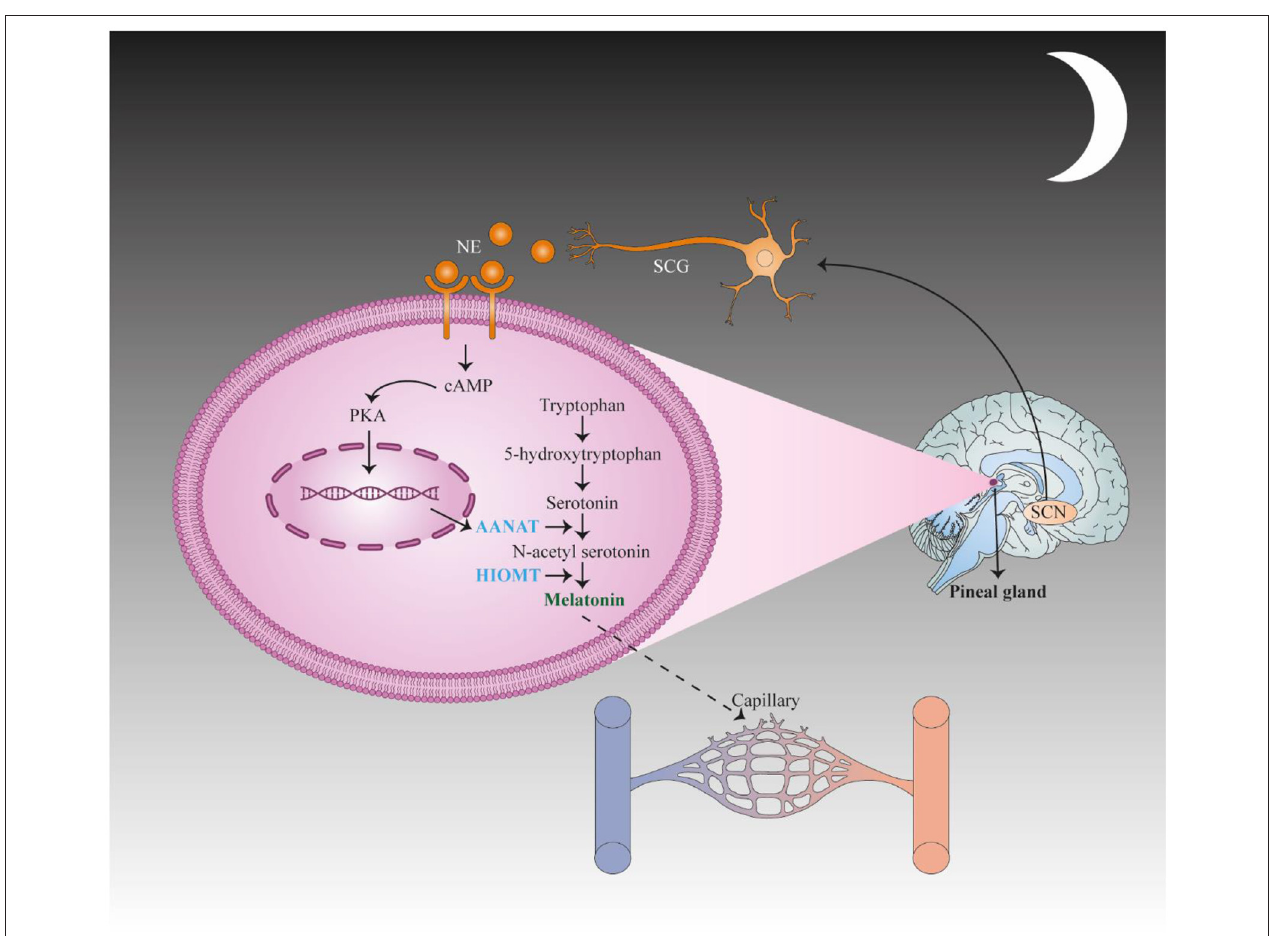
FIGURE 2 | First, the suprachiasmatic nucleus (SCN) translates stimulation to the spinal cord and the superior cervical ganglia (SCG) of the sympathetic nervous system and subsequently activates adrenergic fibers to secrete norepinephrine (NE), which binds to adrenergic receptors in pinealocytes. These changes result in the up regulation of N-acetyltransferase (AANAT), the key enzyme in melatonin synthesis, via activating CAMP signaling. This change causes an increase in the concentration of N-acetyl serotonin, which is converted to melatonin by hydroxyindole-O-methyltransferase (HIOMT). This figure adapted from Song et al.